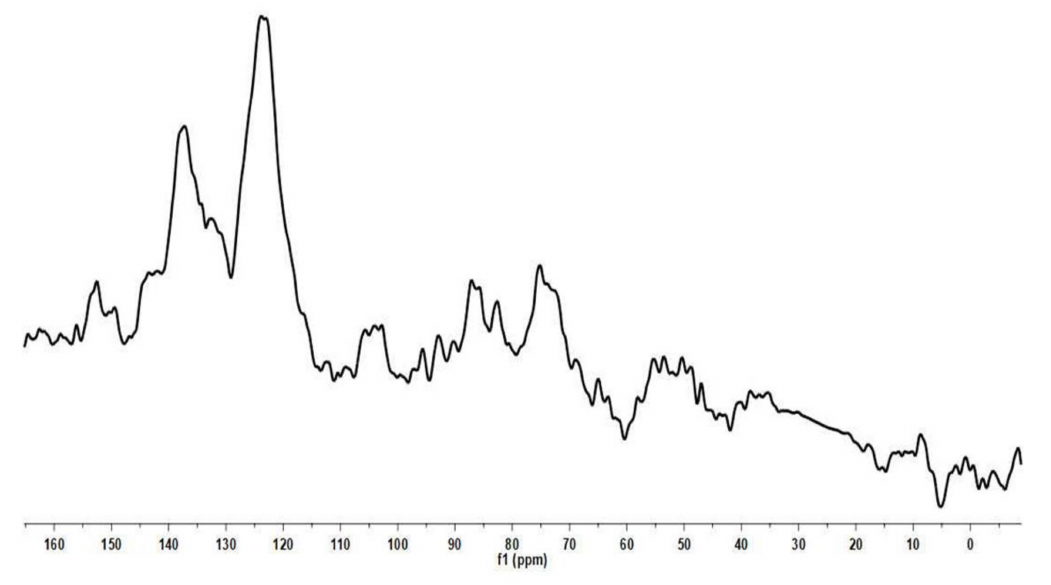
Figure 2. Solid state 13 C NMR spectrum of CPP-P2.